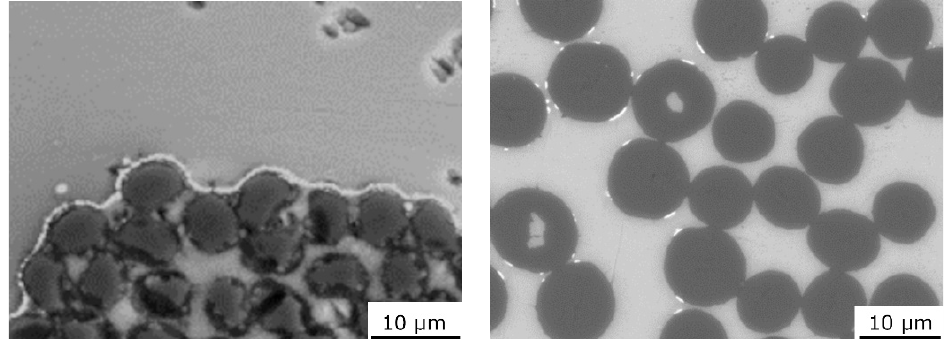
Figure 5. Microstructure of the Mg1.8Y/T300 ( left ) and Mg1.8Y/Granoc ( right ) composites.